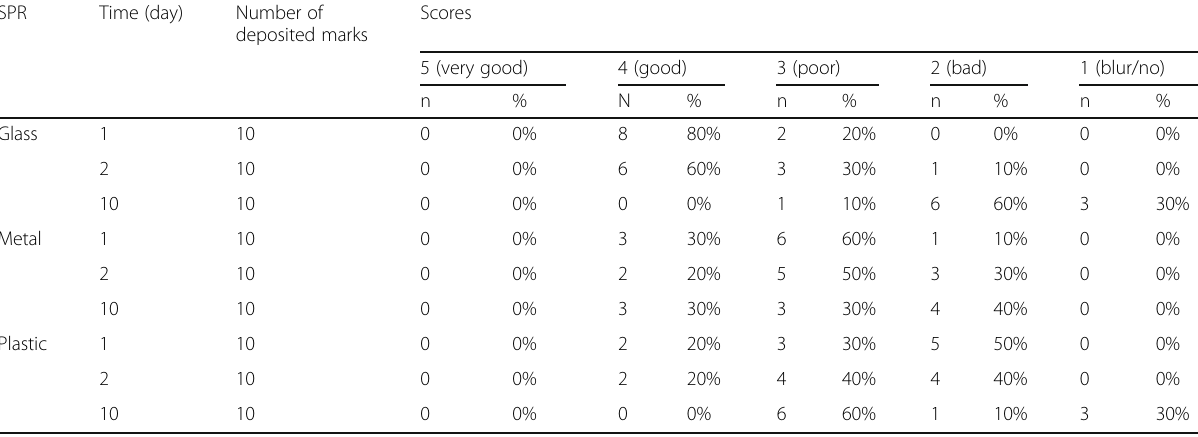
Table 5 Fingerprints development scores using SPR technique on glass, metal and plastic surfaces submerged in fresh water at 1, 2 and 10 days ’ intervals according to fingerprints quality assessment scale SPR